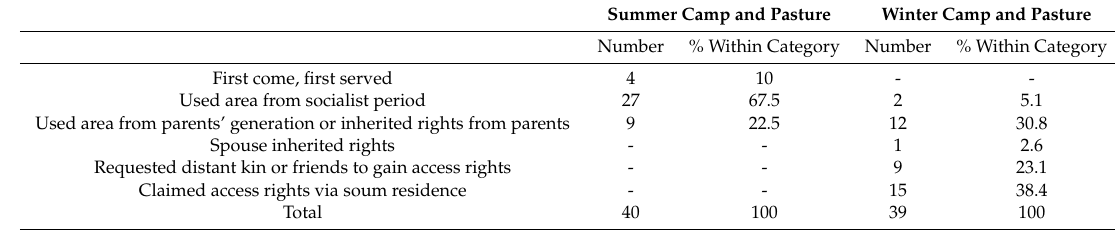
Table 2. SourceofcampselectionandpastureintheAltanbulagsoum. Datasource: Fern á ndez-Gim é nez[36].